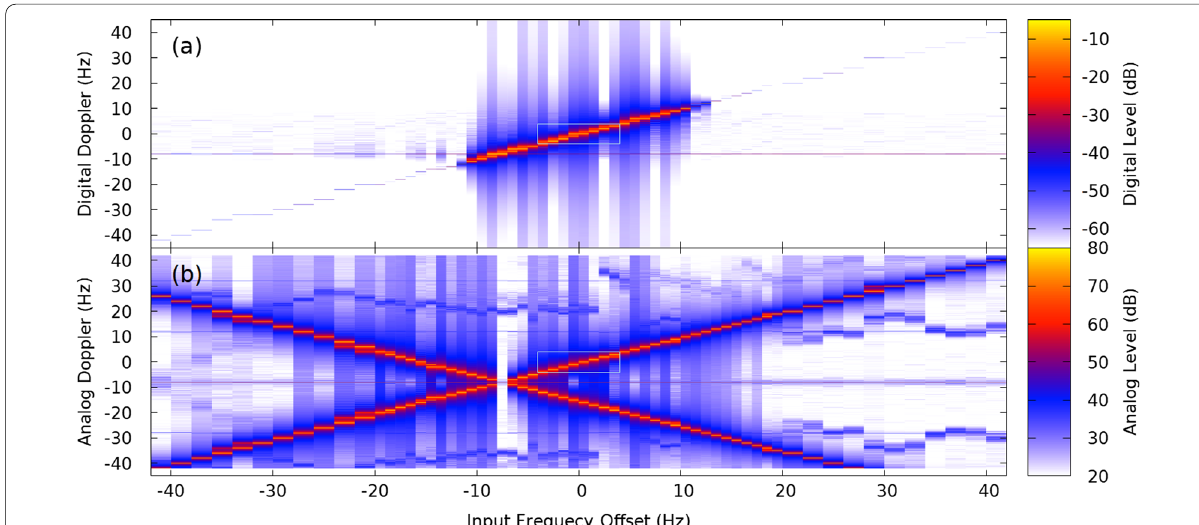
Fig. 7 Dynamic spectra obtained with a the digital receiver and b the analog receiver. The plot shows the response to input frequency in the range from – 40 to 40 Hz with respect to the center frequency of 5006 +